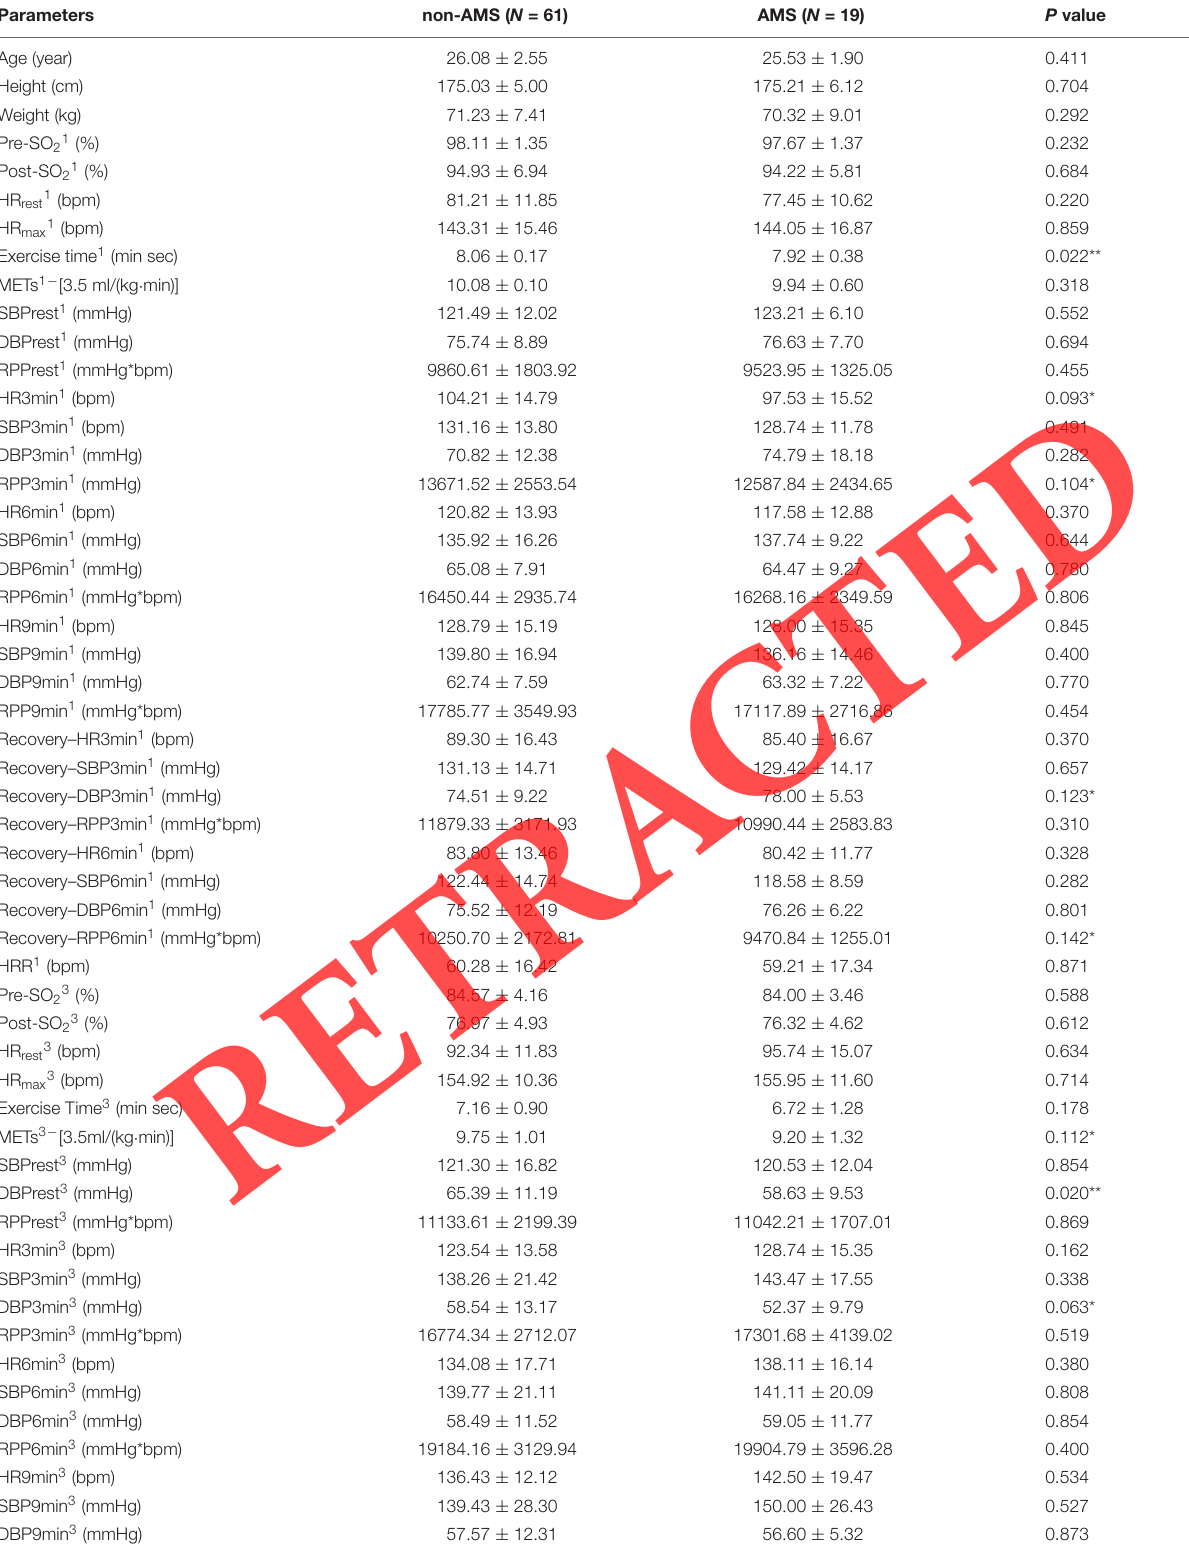
TABLE 3 | Comparison of exercise test parameters between AMS group and non-AMS group.